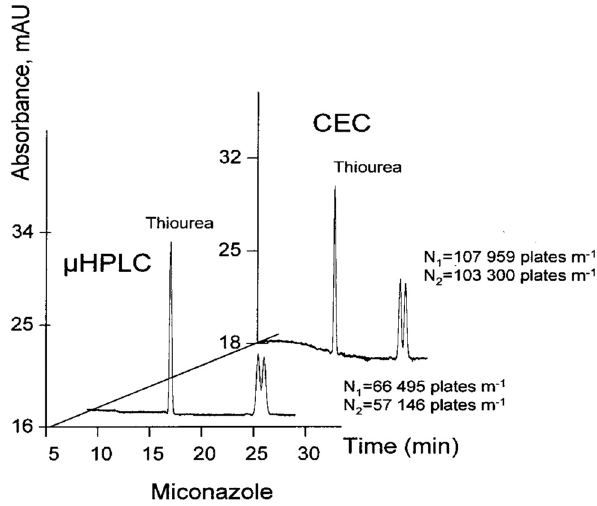
Figure 4: Enantioseparation of miconazole in CEC and CLC mode by using 100 µm ID × 24 cm capillary column packed with CSP - cellulose tris ( 3,5 dichloro phenyl carbamite )- based. Reprinted from ref. [ 104 ]